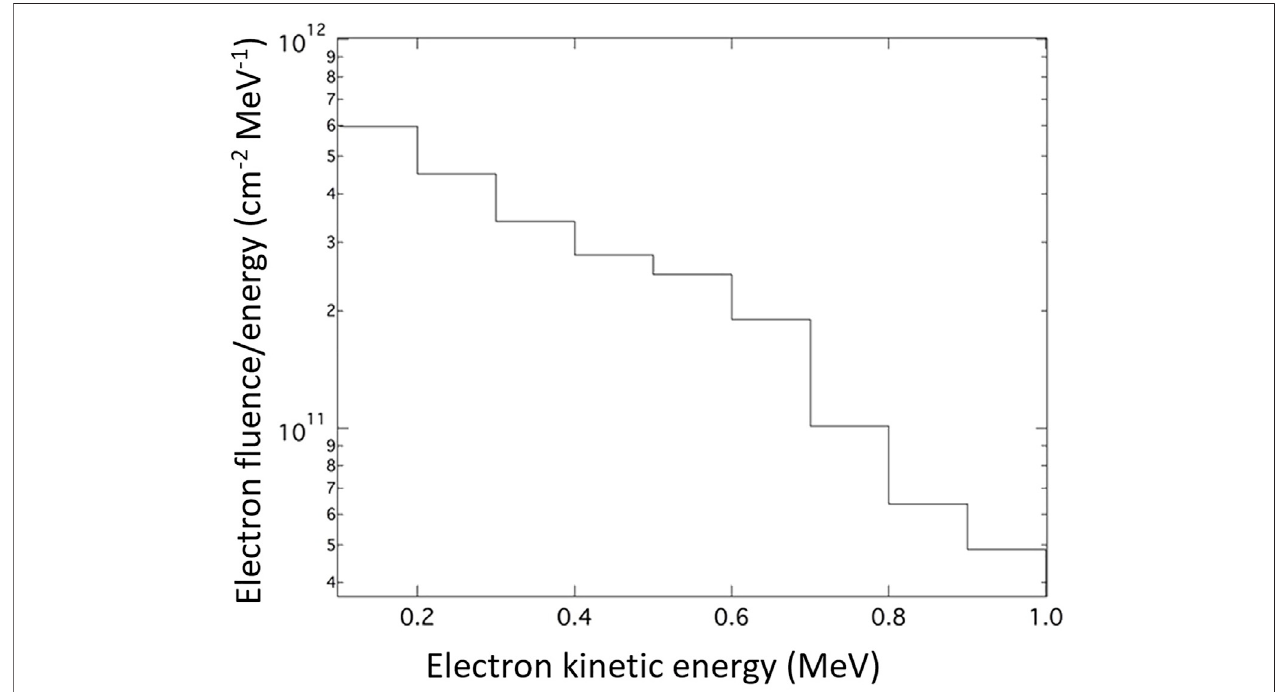
FIGURE 8 | The unfolded electron spectrum in the range between 0.1 – 1 MeV in the direction along the rear target normal.